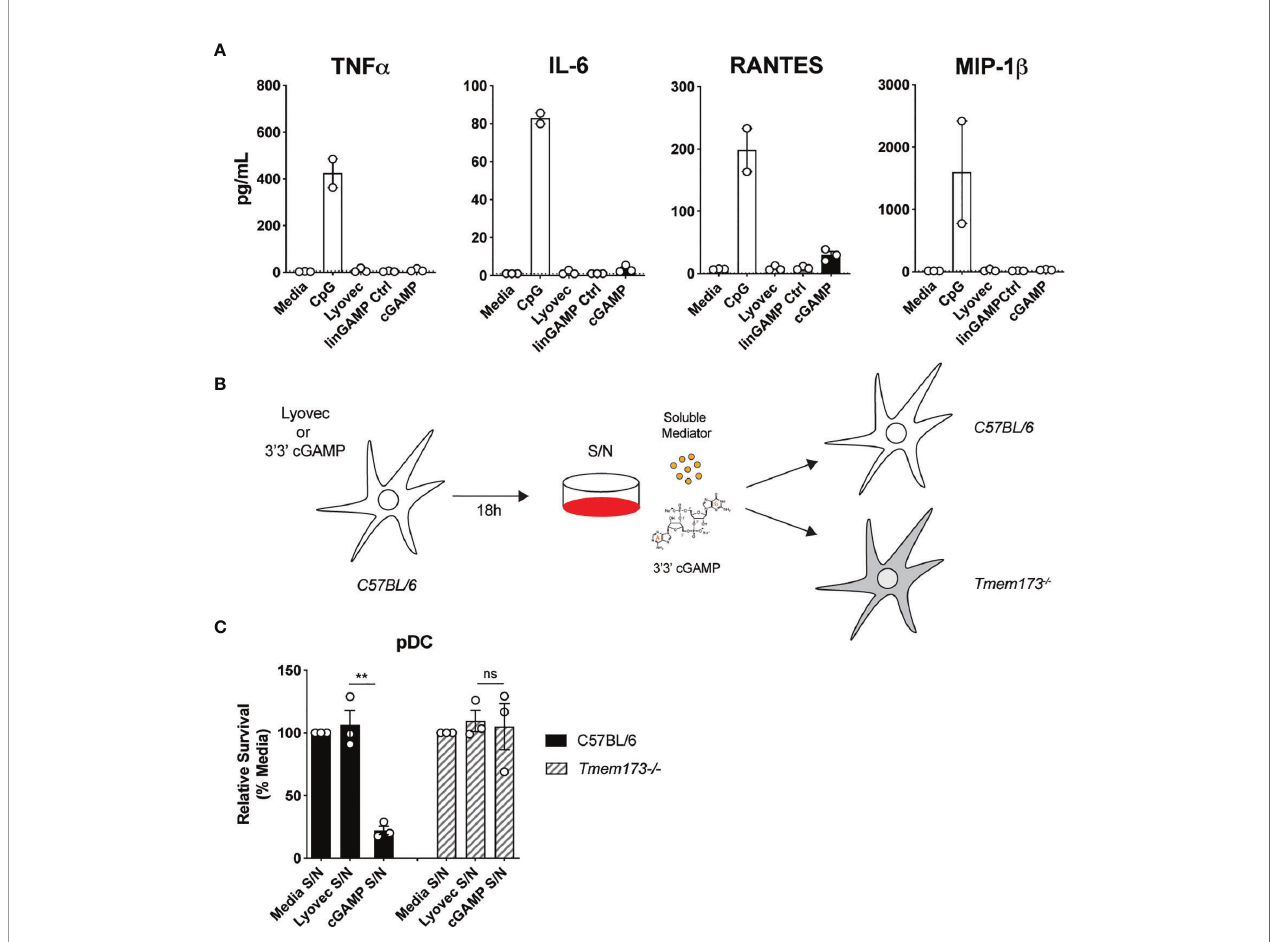
FIGURE 4 | Soluble mediators induced by STING activation are not responsible for pDC death. (A) Sorted splenic pDC from a pool of 15-17 mice were stimulated for 18 hrs with 10 nmol 3 ’ 3 ’ cGAMP or its linearized control ligand (linGAMP Ctrl) complexed with lyovec, lyovec alone or 0.5 m M CpG1668. Cytokine and chemokine production in supernatants were measured by fl ow cytometric bead assay. Bar graphs depict data from 2-3 independent experiments showing mean ± SEM. (B, C) Supernatants harvested 18 h after bulk C57BL/6 DCs were stimulated with 10 nmol 3 ’ 3 ’ cGAMP complexed with lyovec, lyovec alone or media were diluted 1/5 in media and were used to stimulate freshly isolated DCs from C57BL/6 or Tmem173 -/- mice for 18 h. (B) Schematic diagram showing experimental design. (C) Bar graphs show mean relative survival (compared to media supernatant alone) ± SEM from 3 individual mice per genotype. Statistical analysis was performed using two-tailed Paired Student ’ s t test where **P < 0.01 and ns, not signi fi